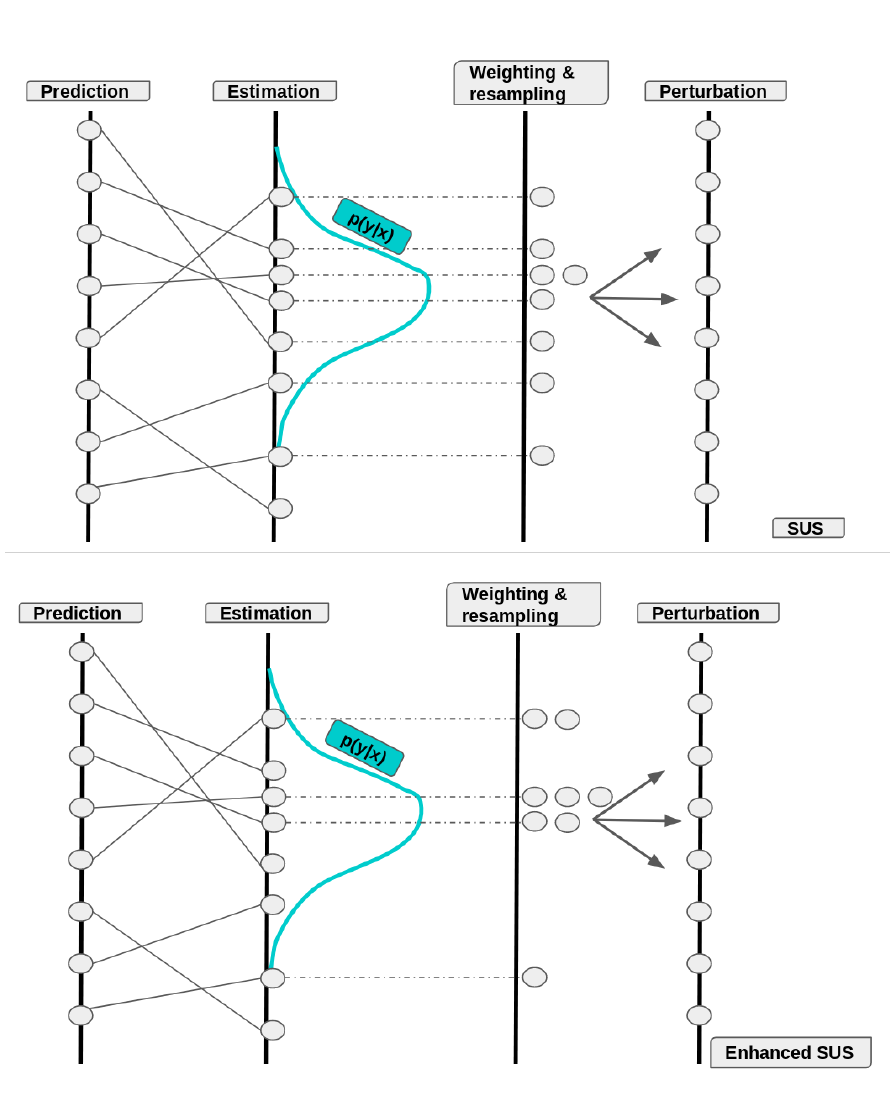
Figure 5. Schema describing the weight calculation and resampling. (1): with initial SUS resampling. (2) with enhanced SUS method.